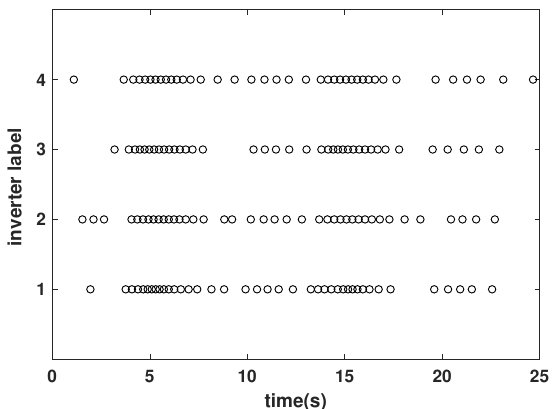
Figure 7. Triggering time instants under event-triggered condition (42) in Case